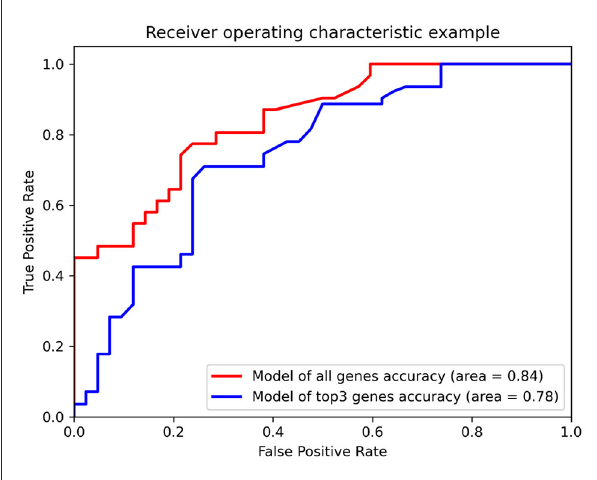
FIGURE4 The receiver operating characteristics (ROC) of the random forest classifier model for the dataset, GSE15222. The red line and the blue line represent the model with all genes and top three hub genes as input, respectively. The area below the line represents the accuracy of the